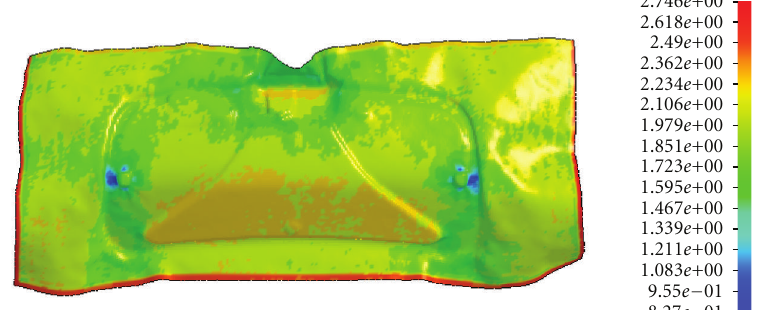
Figure 9: Thickness distribution with forming temperate of 130 ◦ C.